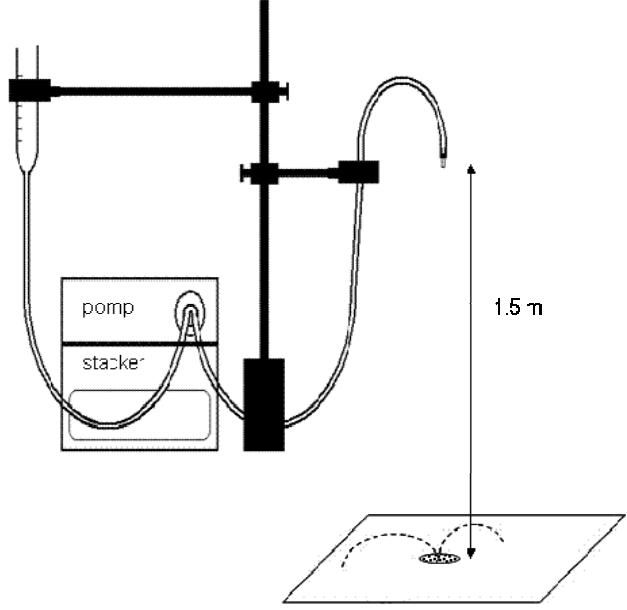
Figure 1. The scheme of the measurement